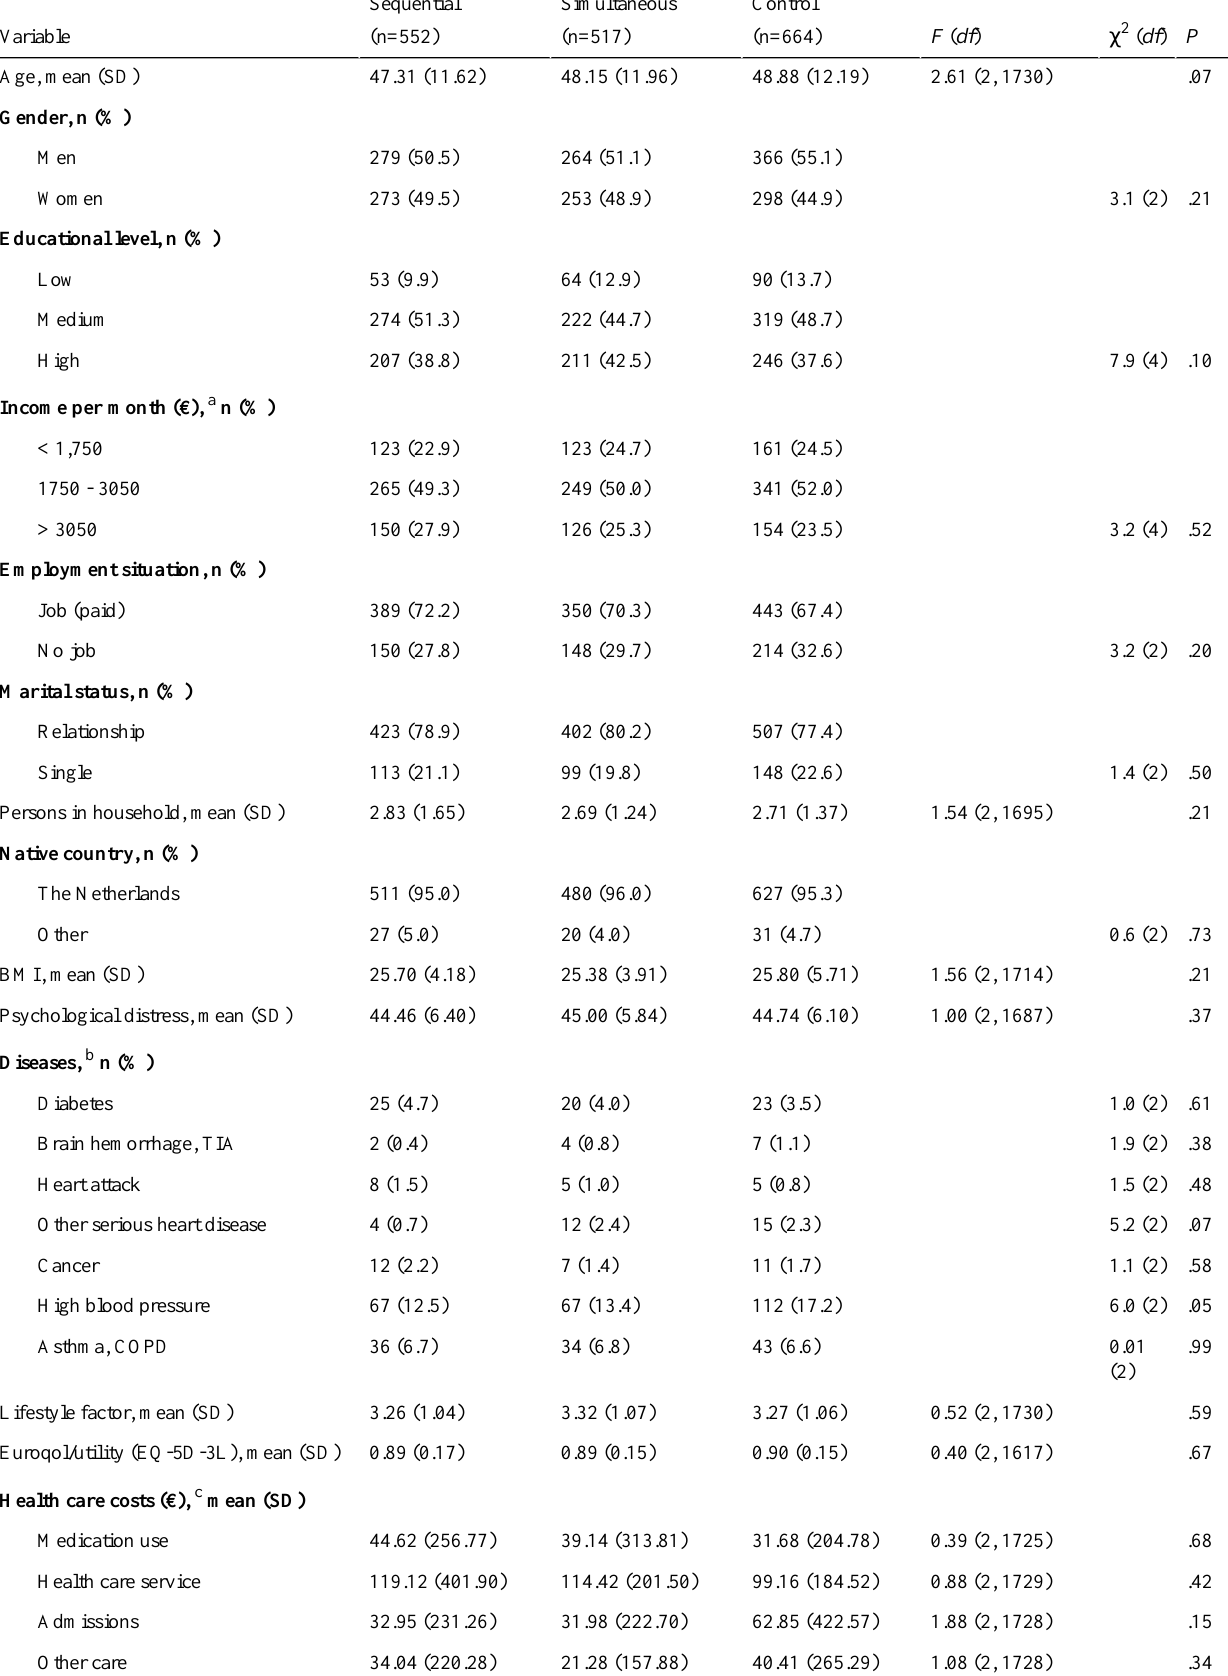
Table 1. Comparability of the 3 study groups regarding demographics, health status, lifestyle behavior, and health care and travel costs over the past 3 months before baseline